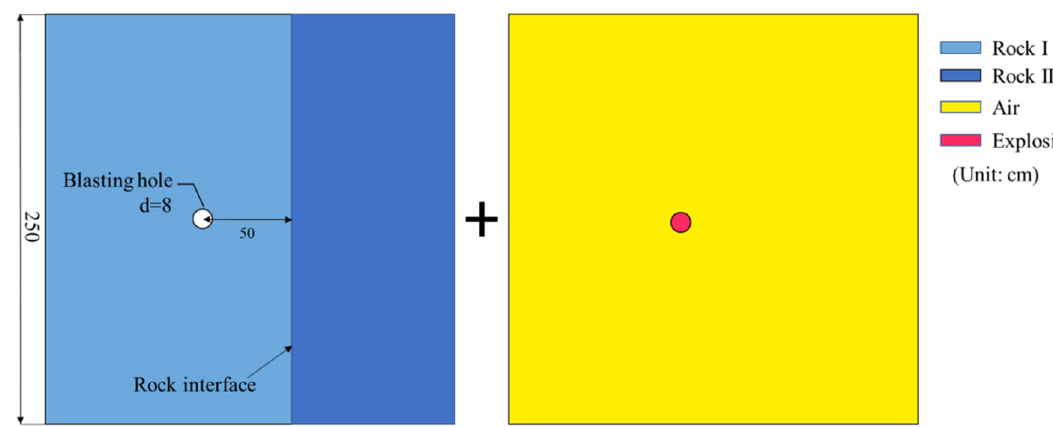
Figure 10. Peak pressure decay.